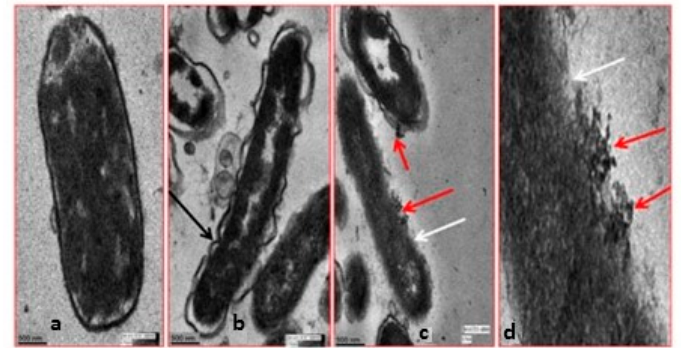
Figure 3. HR-TEM images of E. coli cells: ( a ) untreated; ( b , c ) treated with gum arabic Ag NPs; and ( d ) enlarged view of the membrane of ( c ). Red arrow indicates Ag NPs attachment on membrane and black and white arrows show partially damaged membranes at various sites. Reproduced with permission from John Wiley and Sons [23].